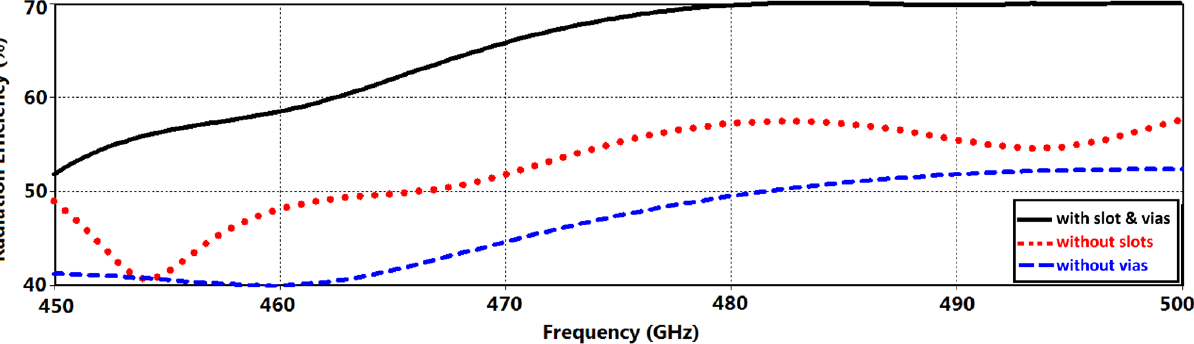
Figure 4. Radiation efficiency as a function of the frequency of the proposed AoC (i) without metamaterial slots, (ii) without metallic vias, and (iii) with metamaterial slots and metallic vias.